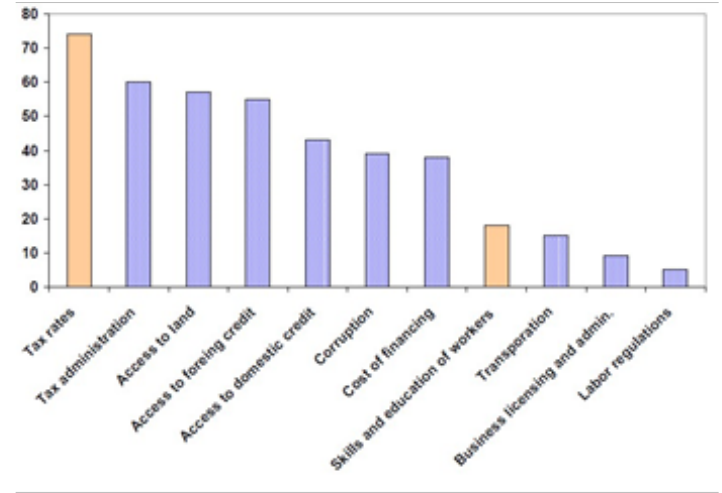
Figure 1: Most cited constraints to SMEs, Source: World Bank